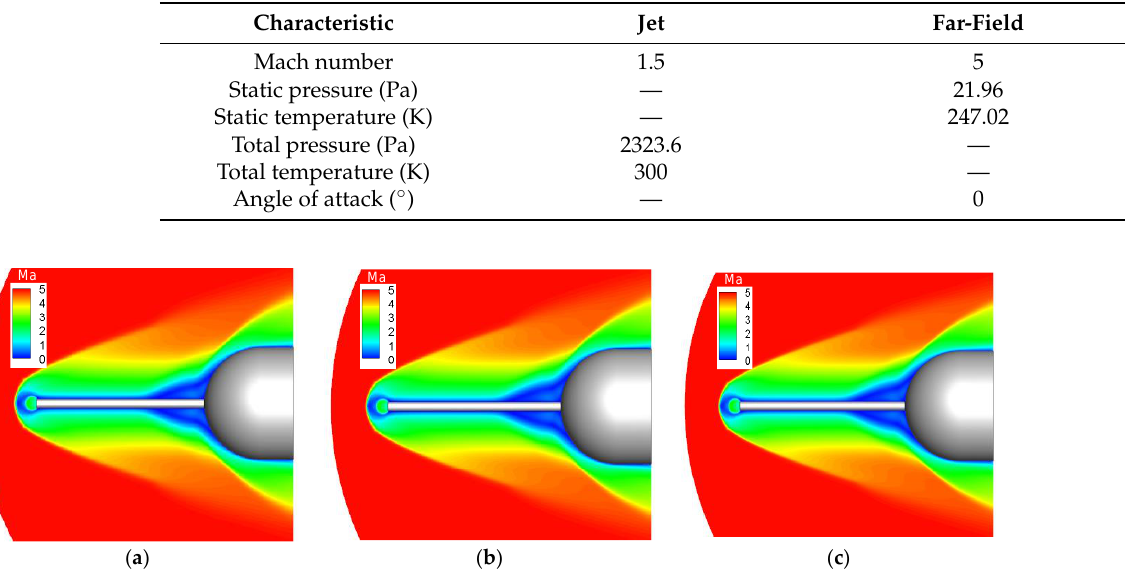
Figure 3. Mach number distribution: ( a ) grid 1 (2345856); ( b ) grid 2 (3801696); ( c ) grid 3 (5593536).